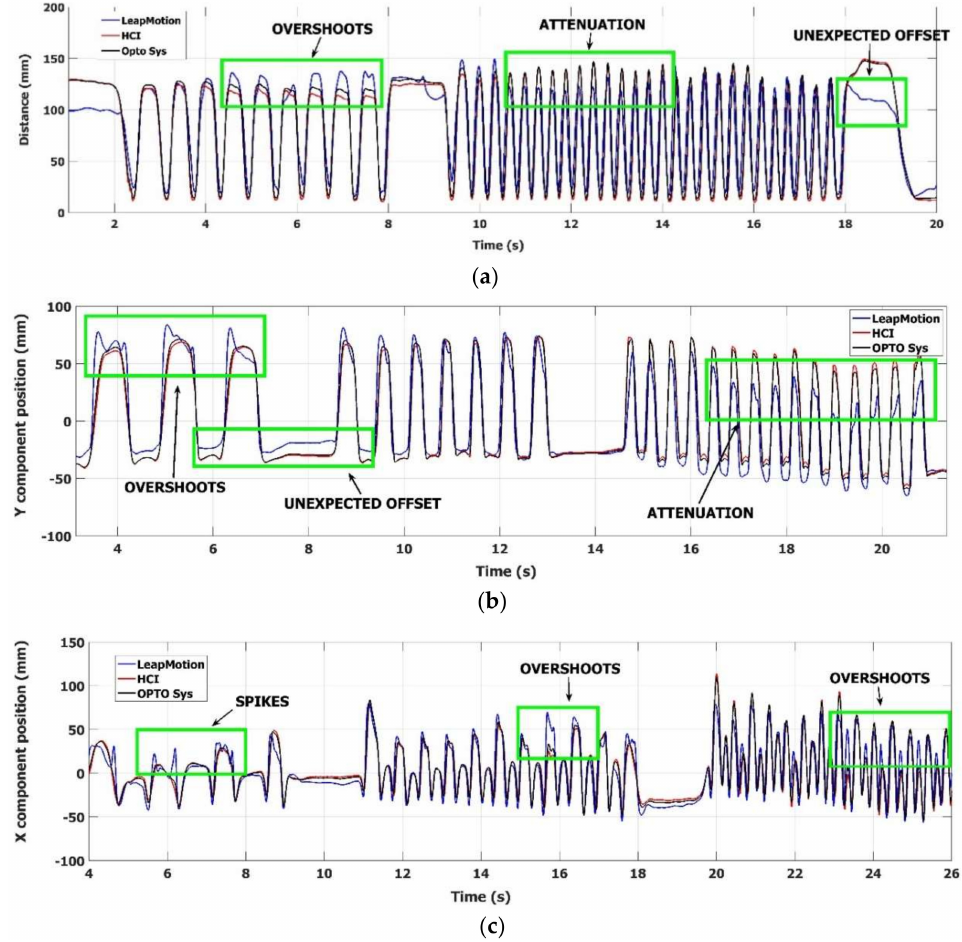
Figure 6. Comparison of the Leap Motion ® tracker (blue solid line), the HCI tracker (red solid line) and the optoelectronic system (black solid line) during the execution of the FT, OC and PS motor tasks. The figures show the trajectories simultaneously measured by the three devices: ( a ) distance between thumb and index trajectories during the FT task; ( b ) Y component of the index trajectory during the OC task; ( c ) X component of the pinky trajectory during the PS task.